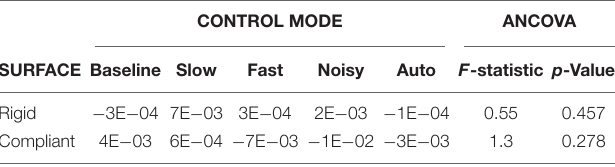
TABLE 1A | Linear regression results on slope (N − 1 msec − 1 ) for each control mode and ANCOVA results across control modes for each surface.